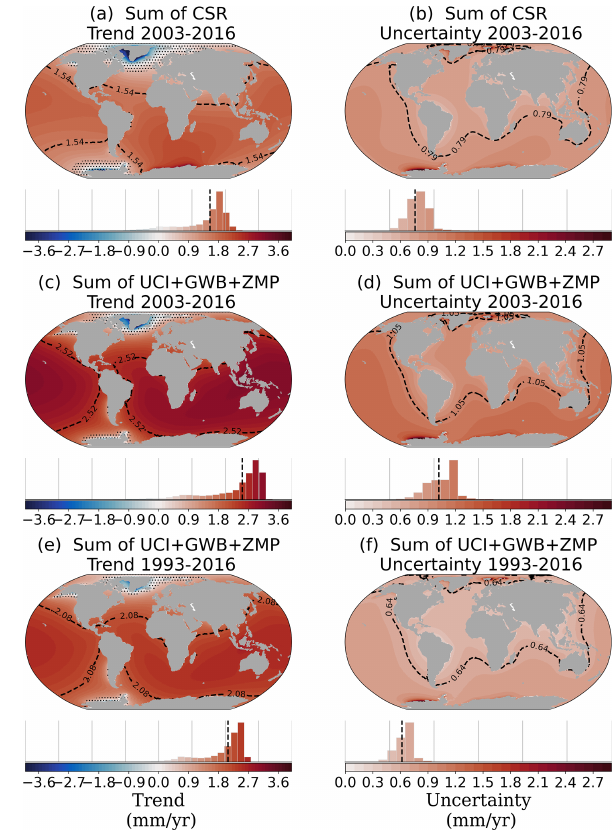
Figure B4. Total GRD-induced SLC fields of the trend and uncer- tainty (mmyr − 1 ) (AIS + GIS + LWS + glacier contributions; in- trinsic + temporal + spatial uncertainties) for GRACE CRS (a, b) and UCI + GlobWEB + Zemp for 2005–2015 (c, d) and for 1993– 2016 (e, f) . Histograms underneath each map indicate the distribu- tion of the regional values across the oceans. Spatial average of the regional trend and uncertainty indicated by black dashed lines in the maps and bar charts. Complementary to trends and uncertainties of Fig. 7.